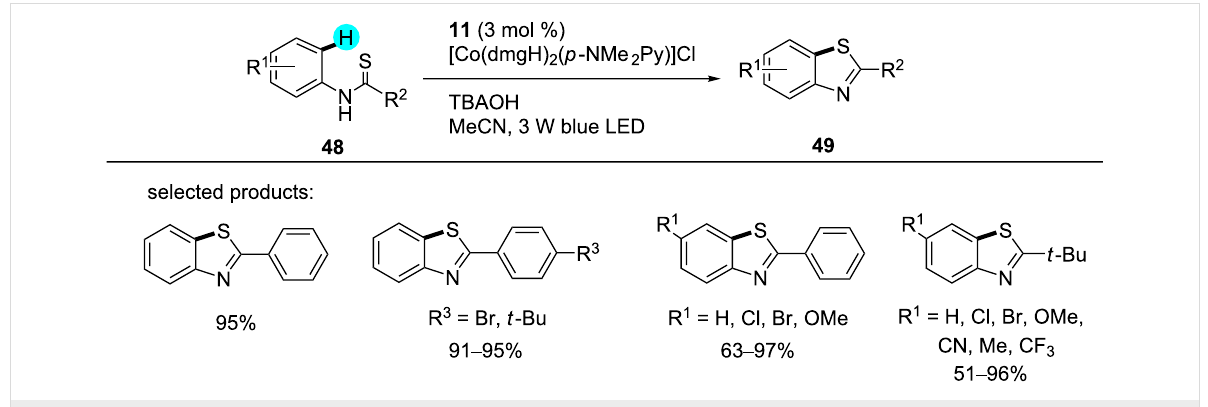
Figure 9: Plausible mechanism for the construction of benzothiazoles from benzothioamides.